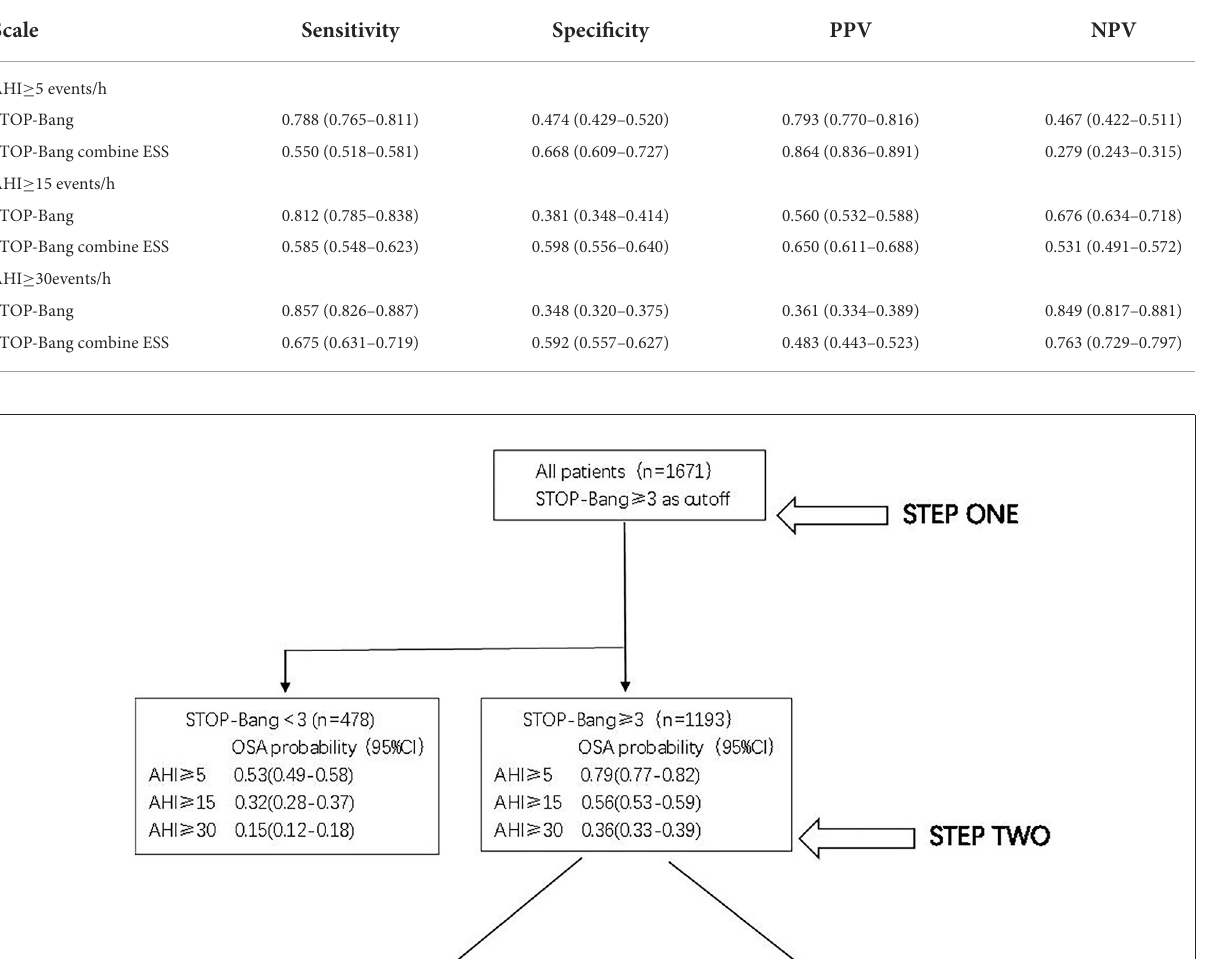
TABLE 4 Compare STOP-Bang combine ESS with STOP-Bang the scale predictors of each group patients [percentage (95%CI)].